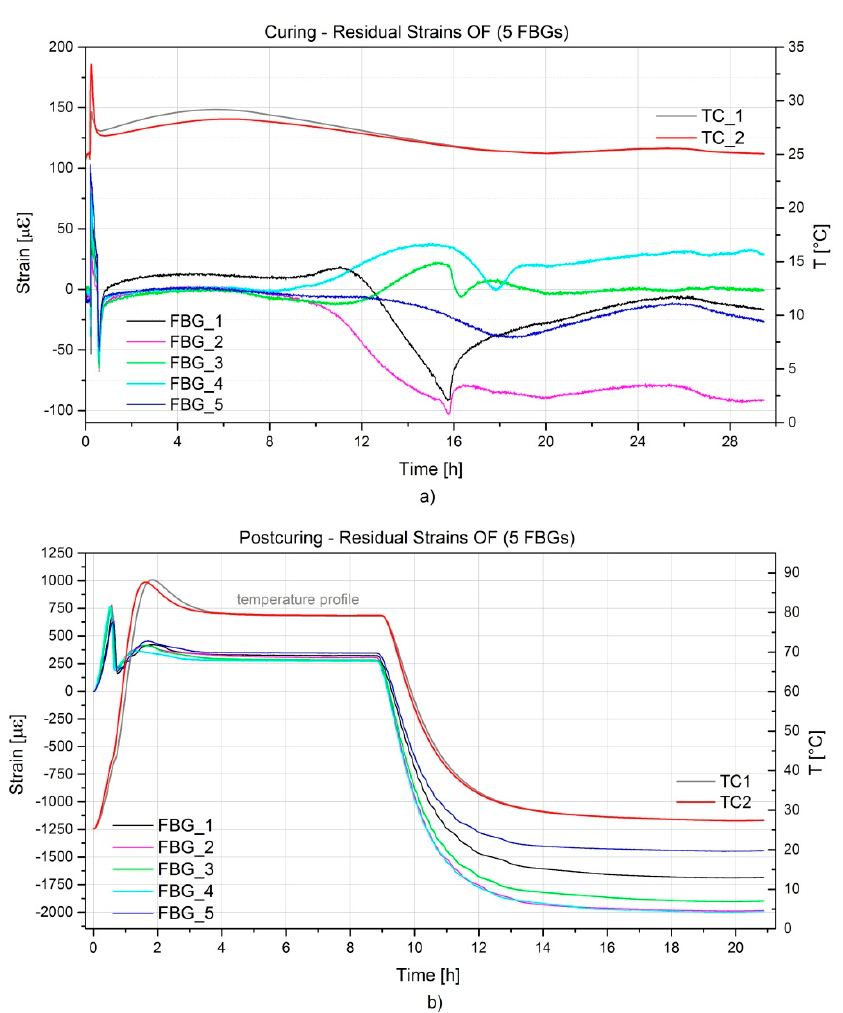
Figure 10. Residual strains evolution during RTM production ( a ) and post-curing ( b ) of the A380 hinge arm.